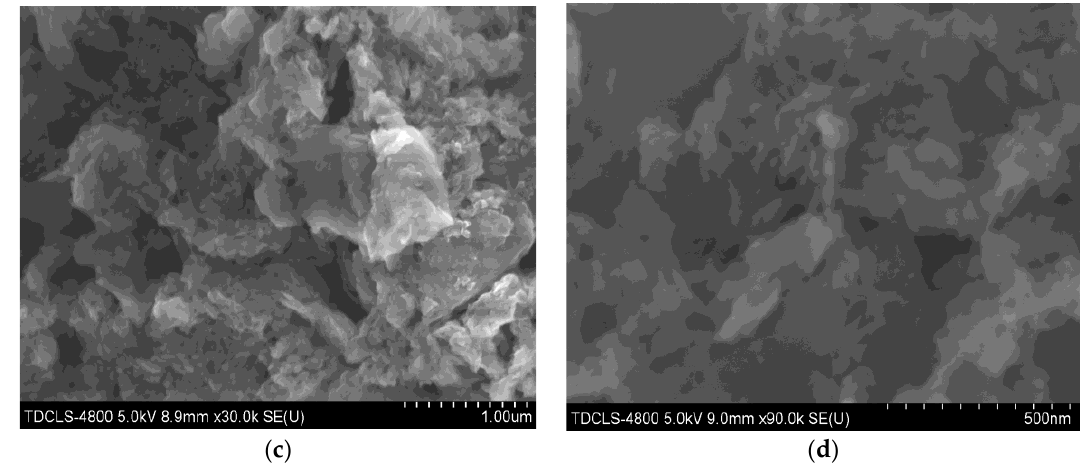
Figure 3. The low magnified SEM and high magnified SEM images of ( a ) C 3 N 4 /ZnO — 0.1 g ( b ) C 3 N 4 /ZnO — 0.2 g ( c ) C 3 N 4 /ZnO — 0.3 g ( d ) C 3 N 4 /ZnO — 0.4 g.